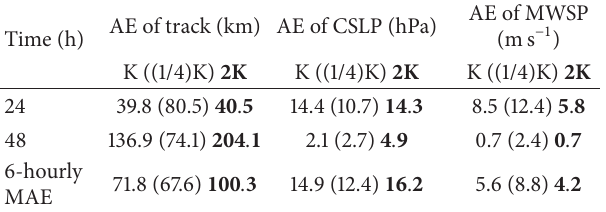
Table 4: Case 3-Genevieve: AE and MAE of track, CSLP, and MWSP.